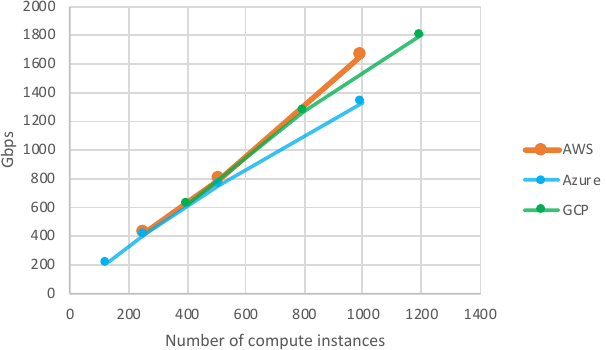
Fig. 1. Peak throughput observed in a Cloud region while downloading from a local object storage instance, for each of the three tested commercial Cloud